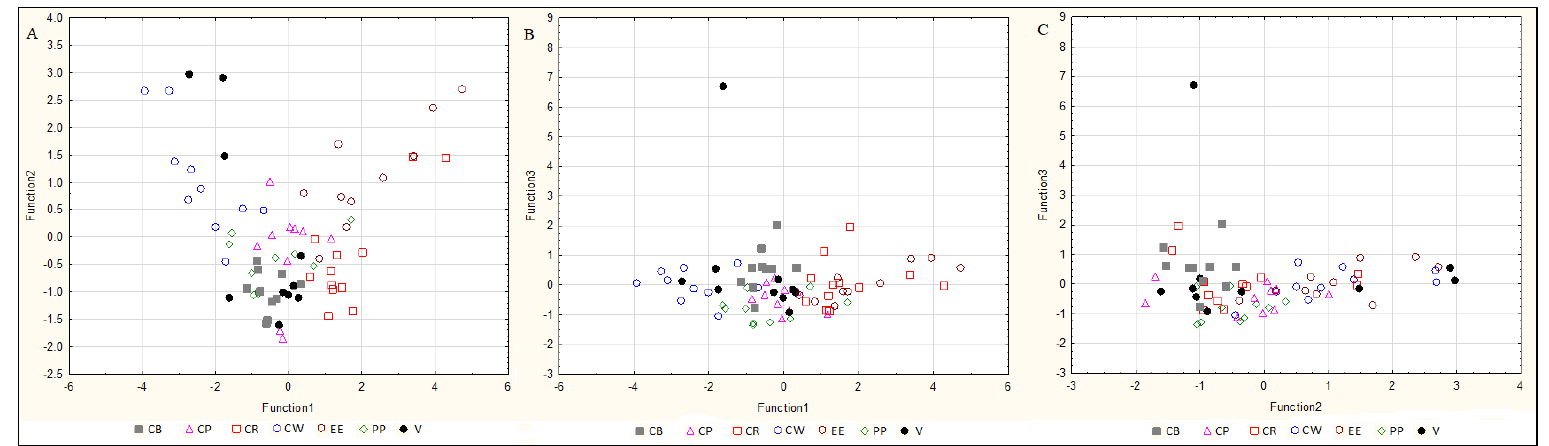
Figure 7. Discriminant analysis of pickled freshwater fish. CB — common bream, CP — common perch, CR — common roach, CW — common whitefish, EE — European eel, PP — pike-perch, V — vendace. ( A ). Function 1 vs. function 2, ( B ). Function 1 vs. function 3, ( C ). Function 2 vs. function 3.